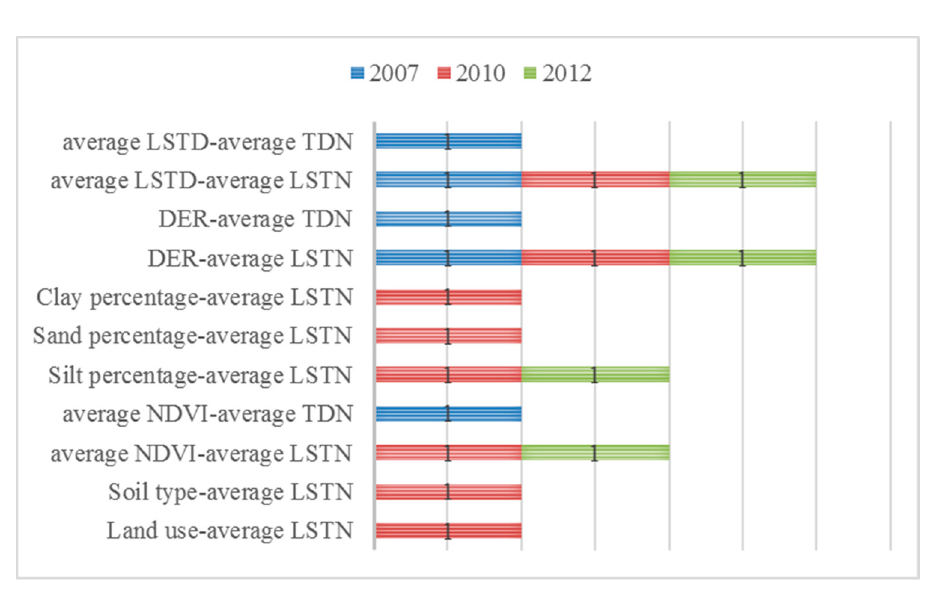
Figure 4. Statistical significance of q-value between different risk factors. Average NDVI, average normalized different vegetation index; DER, distance from the endemic villages to the river; average LSTD, average land surface temperature at daytime; average LSTN, average land surface temperature at night; average TDN, average day and night temperatures. 1 indicates significant differences between the two risk factors, with 95%